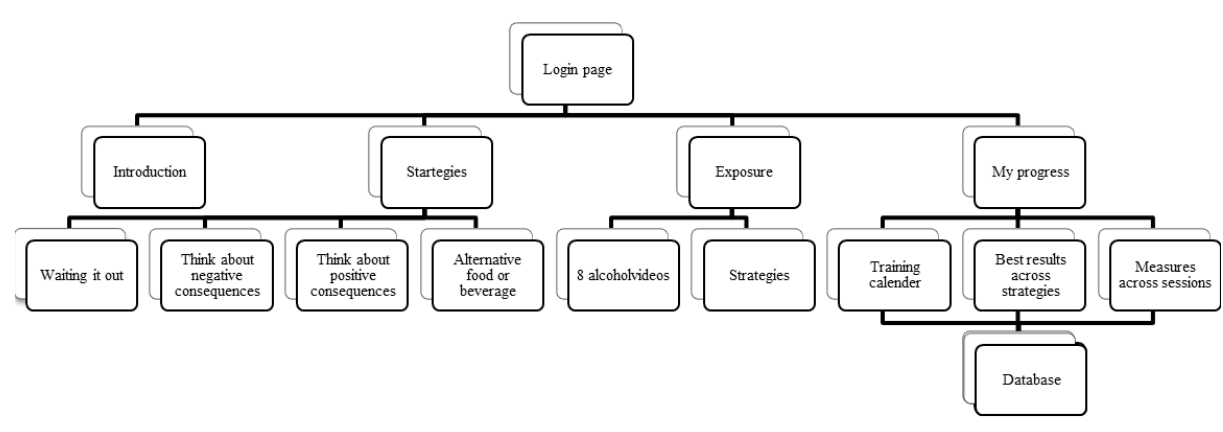
Figure 1. Structure of the cue exposure treatment (CET)